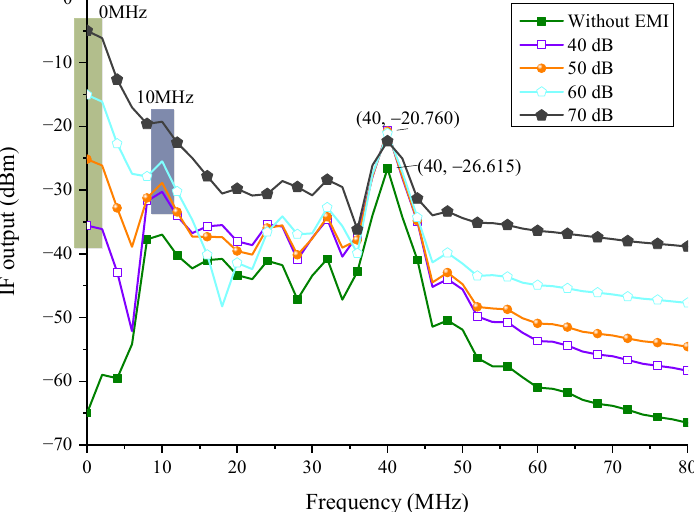
Figure 25. The injection interference law in node 6.